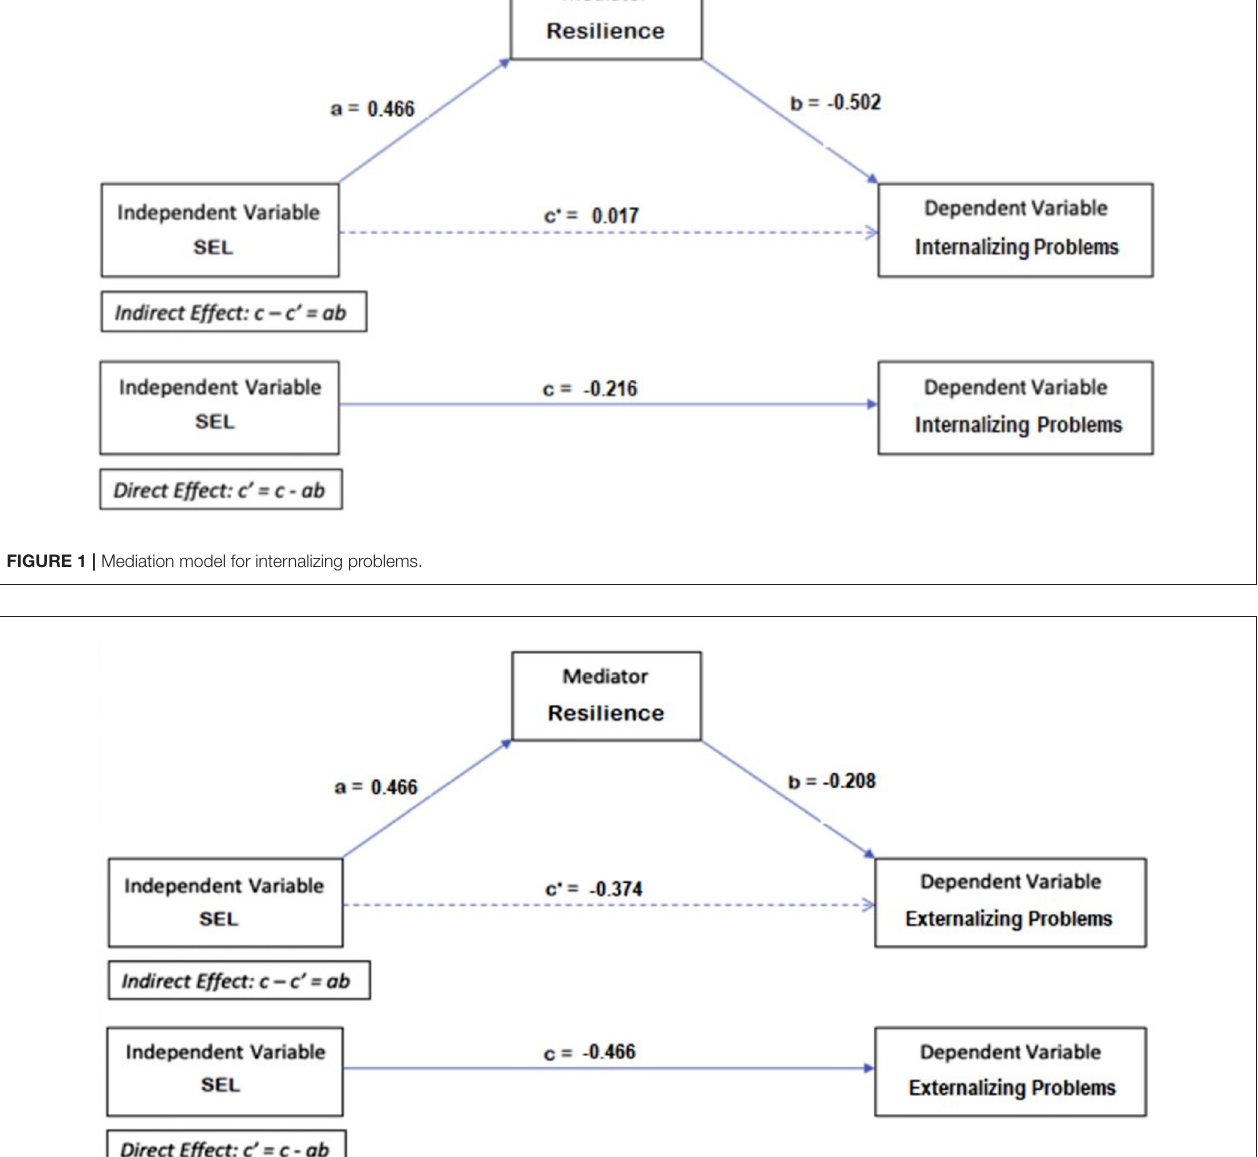
FIGURE 2 | Mediation model for externalizing